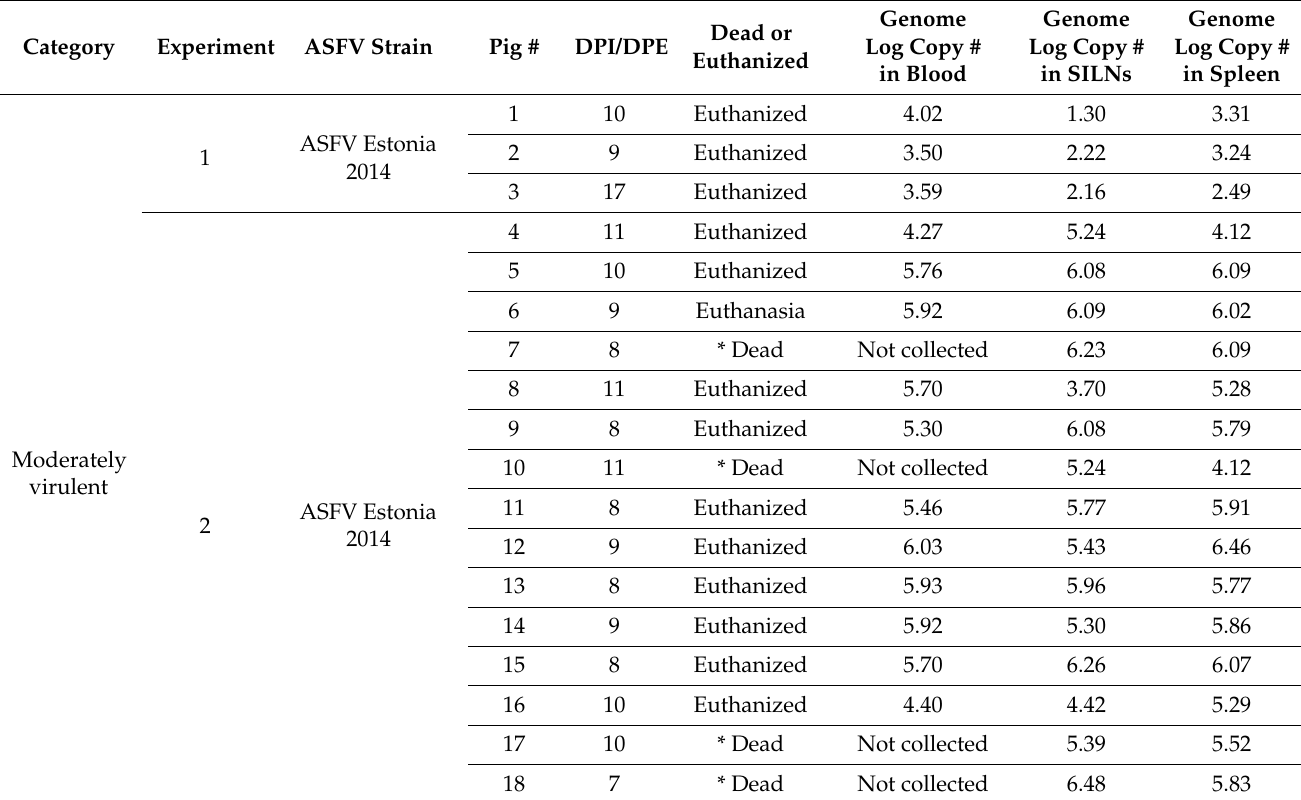
Table 1. ASFV real time PCR detections and genomic copy numbers in whole blood, SILNs and spleens of pigs infected with different ASFV